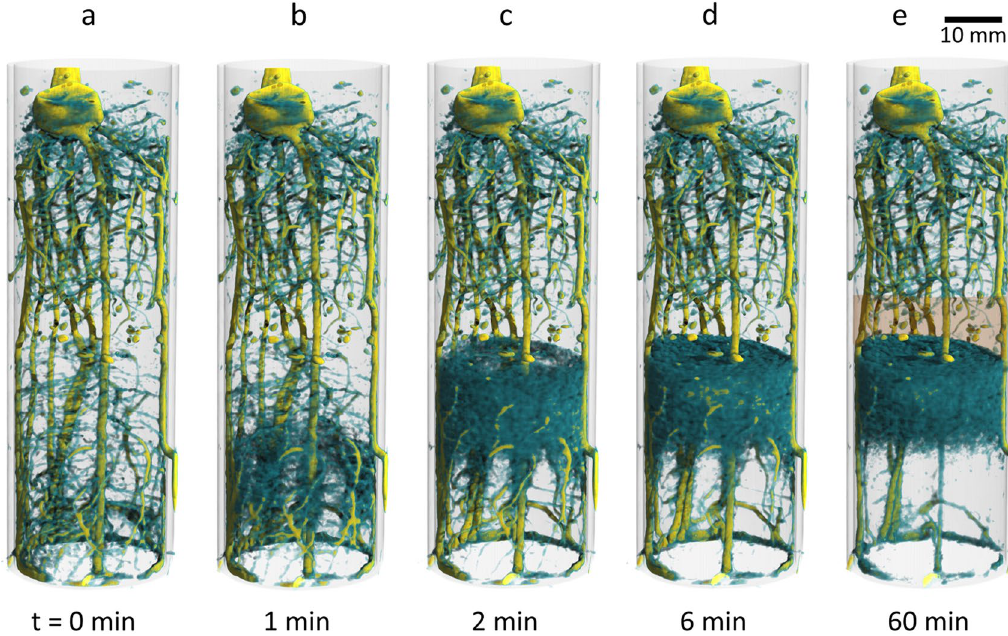
Figure 1. Time-resolved neutron tomography of a 13-days-old maize root system after infiltration of 4 ml deuterated water (D 2 O) through the bottom. ( a–d ) The 3D rendered the time series shows that D 2 O displaced the existing H 2 0 that built up to an upward moving water front and accumulated underneath the hydraulic barrier layer (indicted as brown-shaded area in ( e ). After 6 min, the dynamic part of soil water redistribution was completed. The volumetric water content of the lower soil compartment increased from θ H2O = 0.1 to θ liquid = 0.27 cm 3 /cm 3 as result of the infiltration. Roots located in the bottom compartment appeared